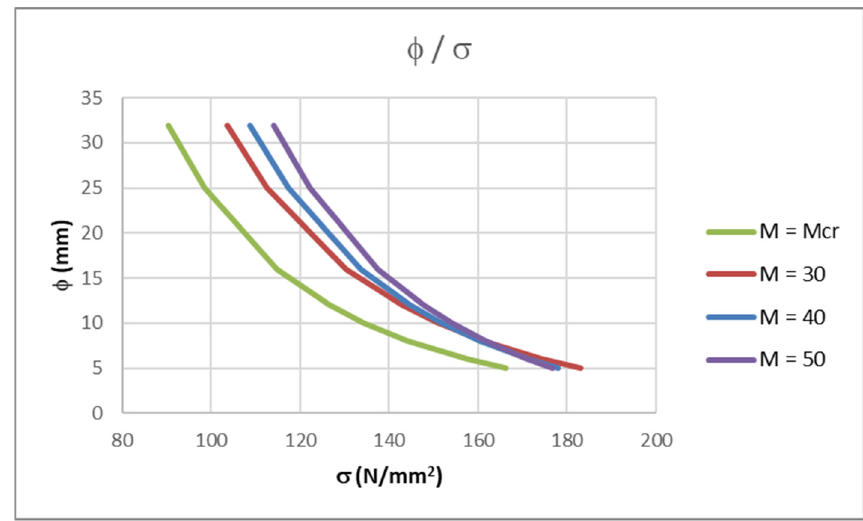
Figure 5. Results of parametric analysis.